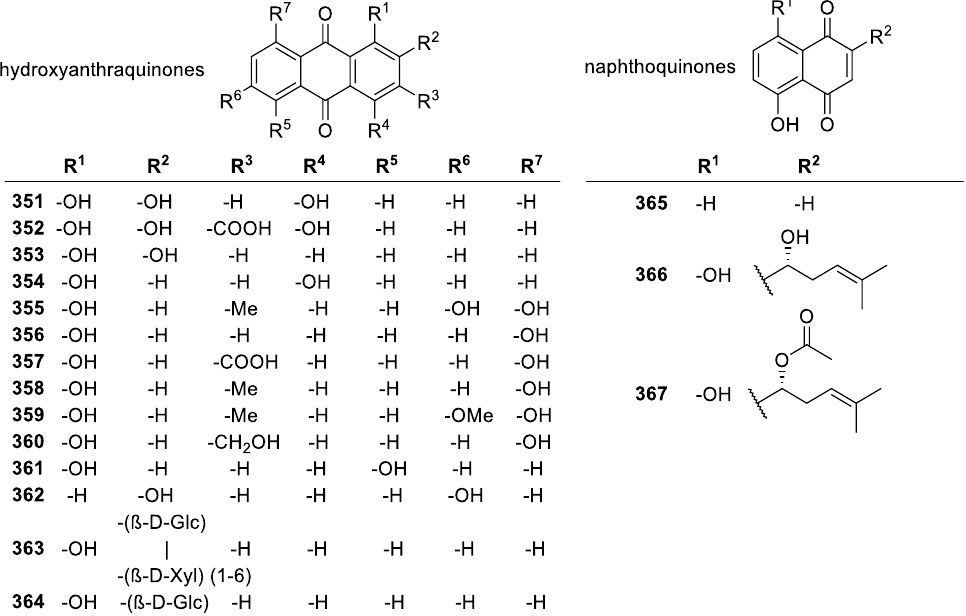
Figure 25. Structures of hydroxyanthraquinones and naphthoquinones.